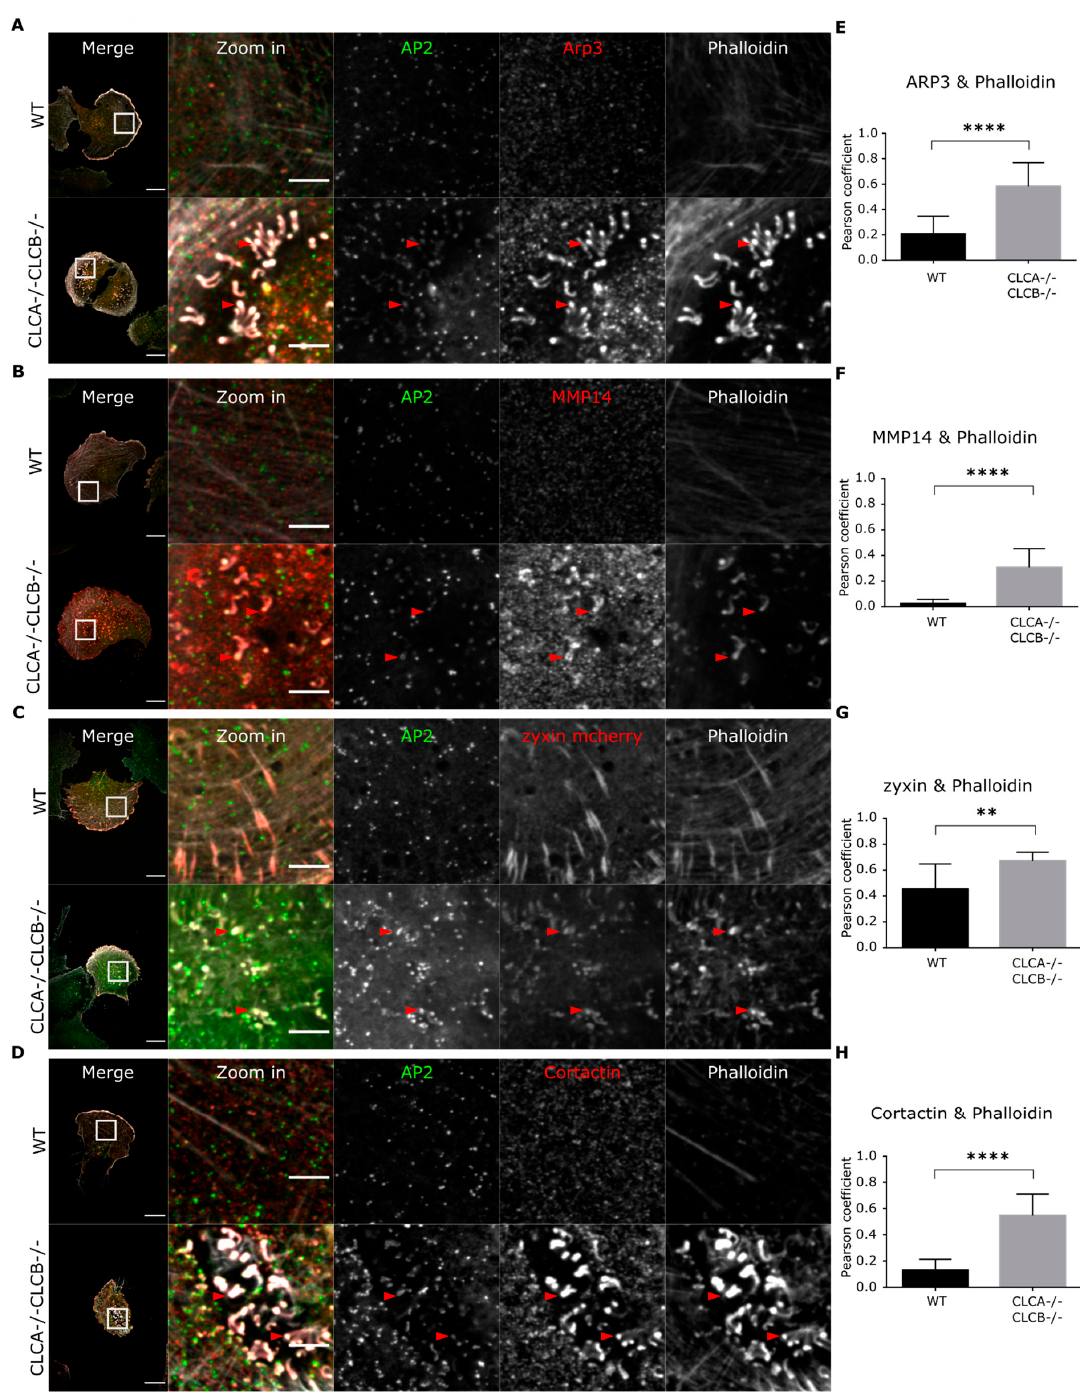
Figure 3. Actin patches in CLCA − / − CLC − / − cells co-localize with common invadopodia markers. U373 AP2-GFP WT and CLTA − / − CLTB − / − cells were fixed 24 h post seeding. Cells were stained with an antibody against ( A ) Arp3 (red) ( B ) MMP14 ( D ) Cortactin (red) or transduced with ( C ) BacMam expressing mCherry-zyxin (red). Cells were analyzed by confocal microscopy for co-localization with AP2 (green) and actin (grey). Representative confocal images are shown. The scale bar represents 20 µm for the merge and 5 µm for the zoom region, respectively. Red arrows indicate co-localizing structures. ( E – H ) Pearson correlation analysis. Shown are the mean with SD. Statistical analysis: unpaired t -test. ARP3 8 fields of view, **** p < 0.0001; MMP14 13 fields of view, **** p < 0.0001; zyxin, 12 fields of view, ** p = 0.0014; Cortactin 11 fields of view, **** p < 0.0001.